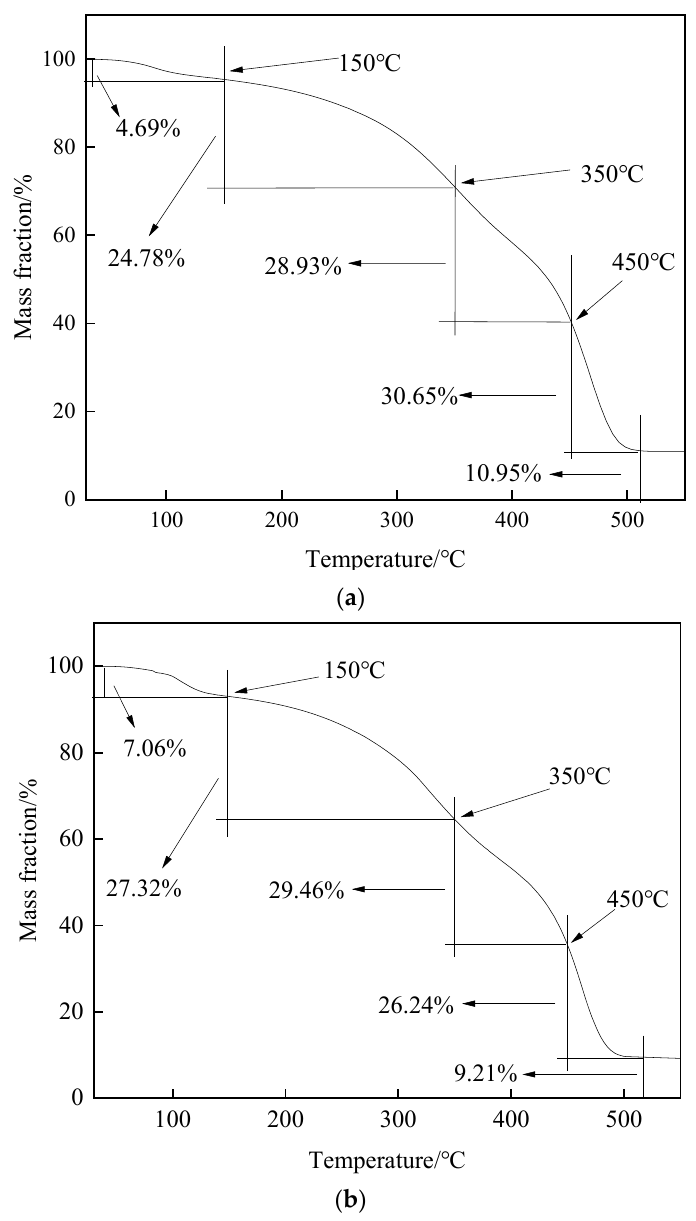
Figure 5. The TG curves of heavy oil before ( a ) and after ( b ) aquathermolysis.